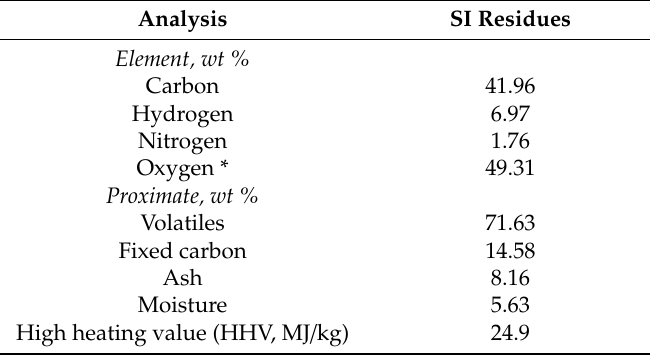
Table 4. Elemental and proximate analyses of SI residues.